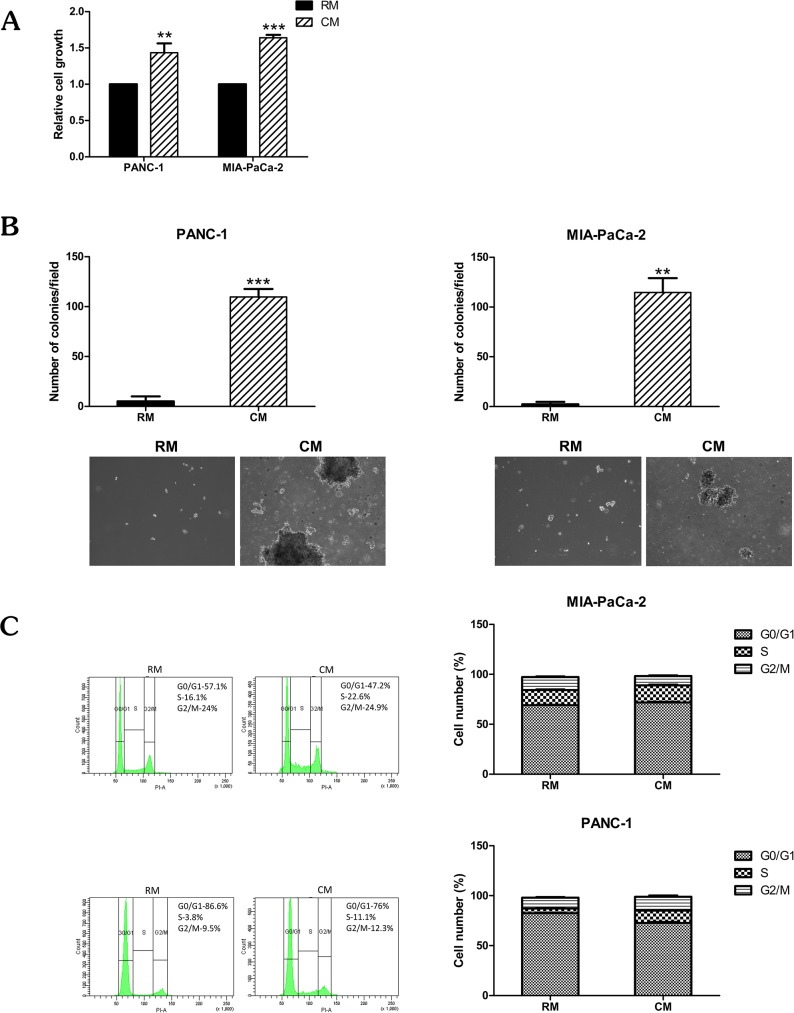
Omental fat CM enhances pancreatic cancer cell growth.(A) XTT assay demonstrating a significant increase (P< .01) in proliferation of pancreatic cancer cells after incubation with omental fat CM, n = 7; (B) Omental fat CM markedly increased pancreatic cancer cell colony formation capacity (P< .01). The upper panel graphs represent the average of four repeated independent experiments ±SD, and the lower panel depicts representative images of cell colonies in soft agar (magnification, X100); (C) Omental fat CM-induced S-phase population in pancreatic cancer cells; a more pronounced effect was seen in PANC-1 cells than in MIA-PaCa-2 cells (P< .05). Bar plots display the data of 7 independent experiments.